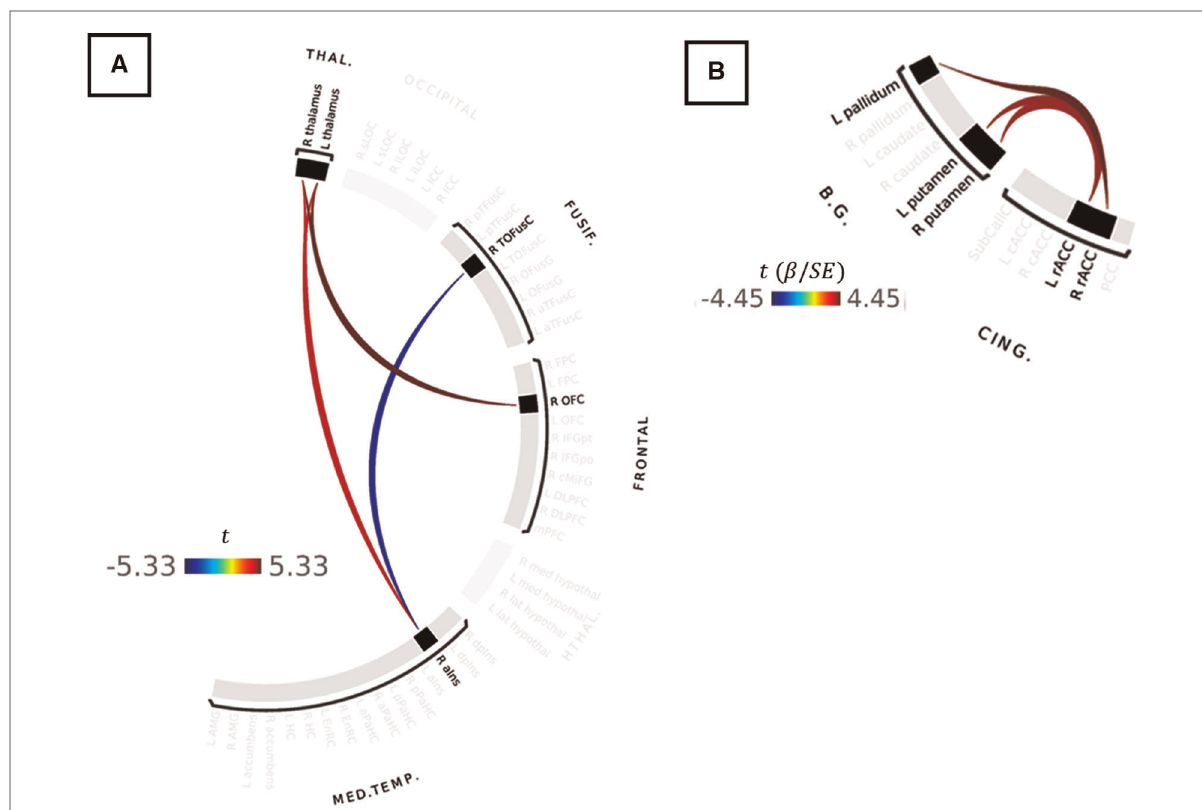
FIGURE 4 ( A ) Results of paired-samples t -test between cuff-in fl ated and cuff-de fl ated conditions for TMD participants. Red colors indicate stronger correlations between ROIs in the in fl ated condition, compared to de fl ated, whereas blue colors indicate weaker ROI-ROI correlations in the in fl ated condition compared to de fl ated. Color bar indicates the t -statistic. ( B ) Correlations between ROI-ROI connection strength and symptom severity in the in fl ated condition for all participants. Color bar indicates the Wald t -statistic for the GLM coef fi cient. No statistically-signi fi cant differences in connectivity strength were observed between TMD or control participants in the in fl ated or de fl ated conditions, or within TMD or control participants as a function of Pennebaker Hypervigilance, ACRFS Symptom Severity, or ACRFS WPI scores following correction for multiple comparisons using network-based